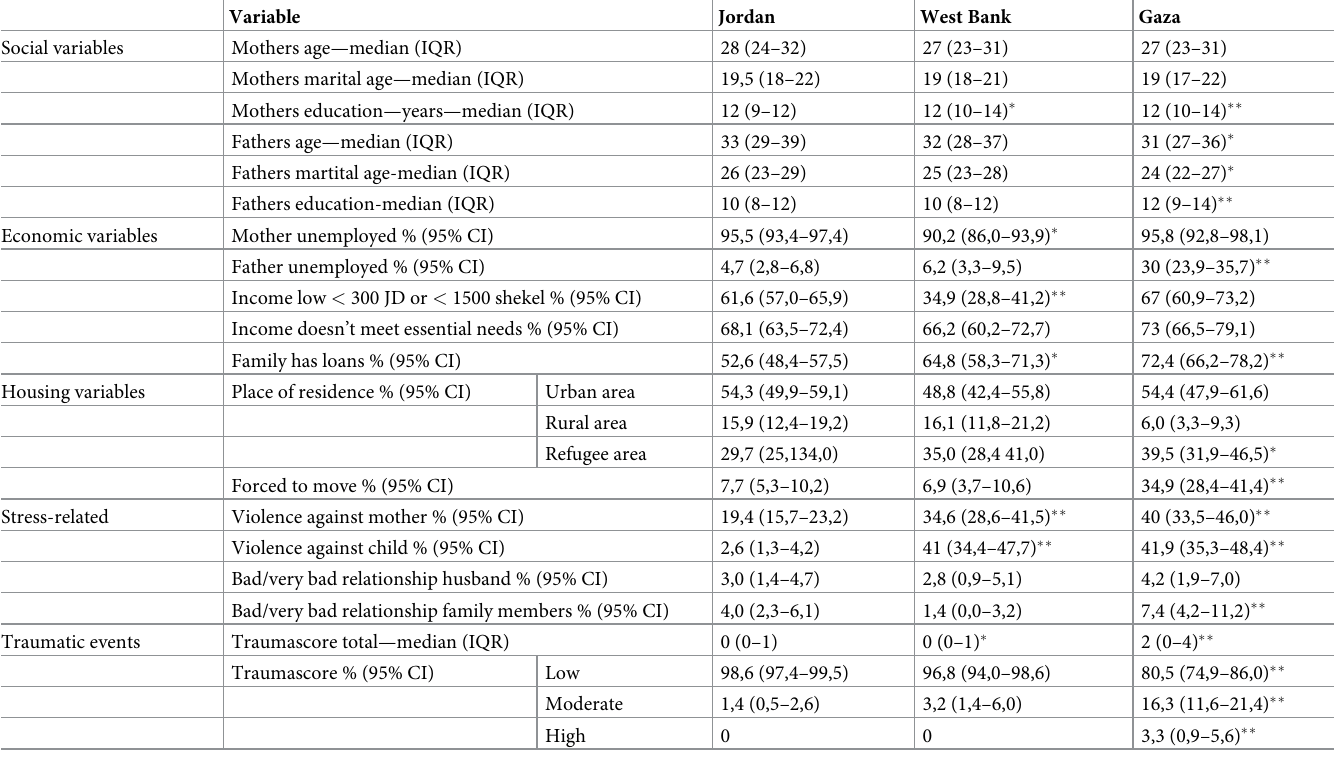
Table 2. Social-economic data and variables related to psychosocial stress and trauma in the different